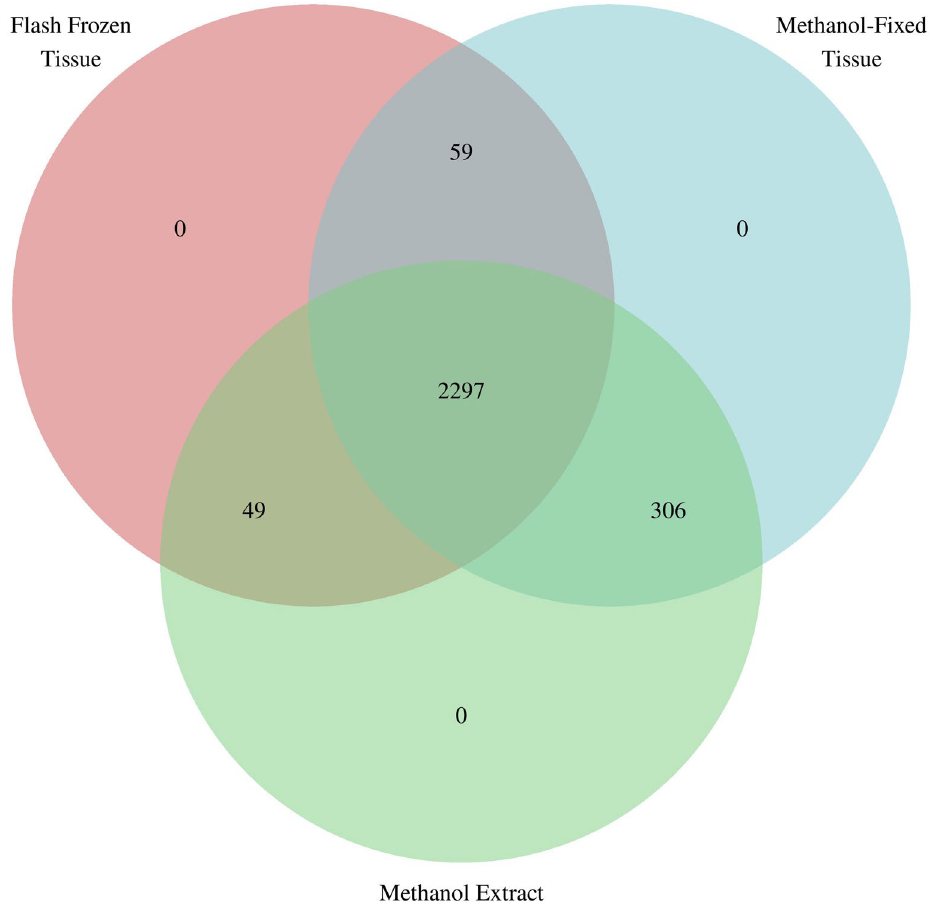
Figure 4. Number of metabolite features shared across the three sample types (flash frozen tissue, methanol- fixed tissue, and methanol